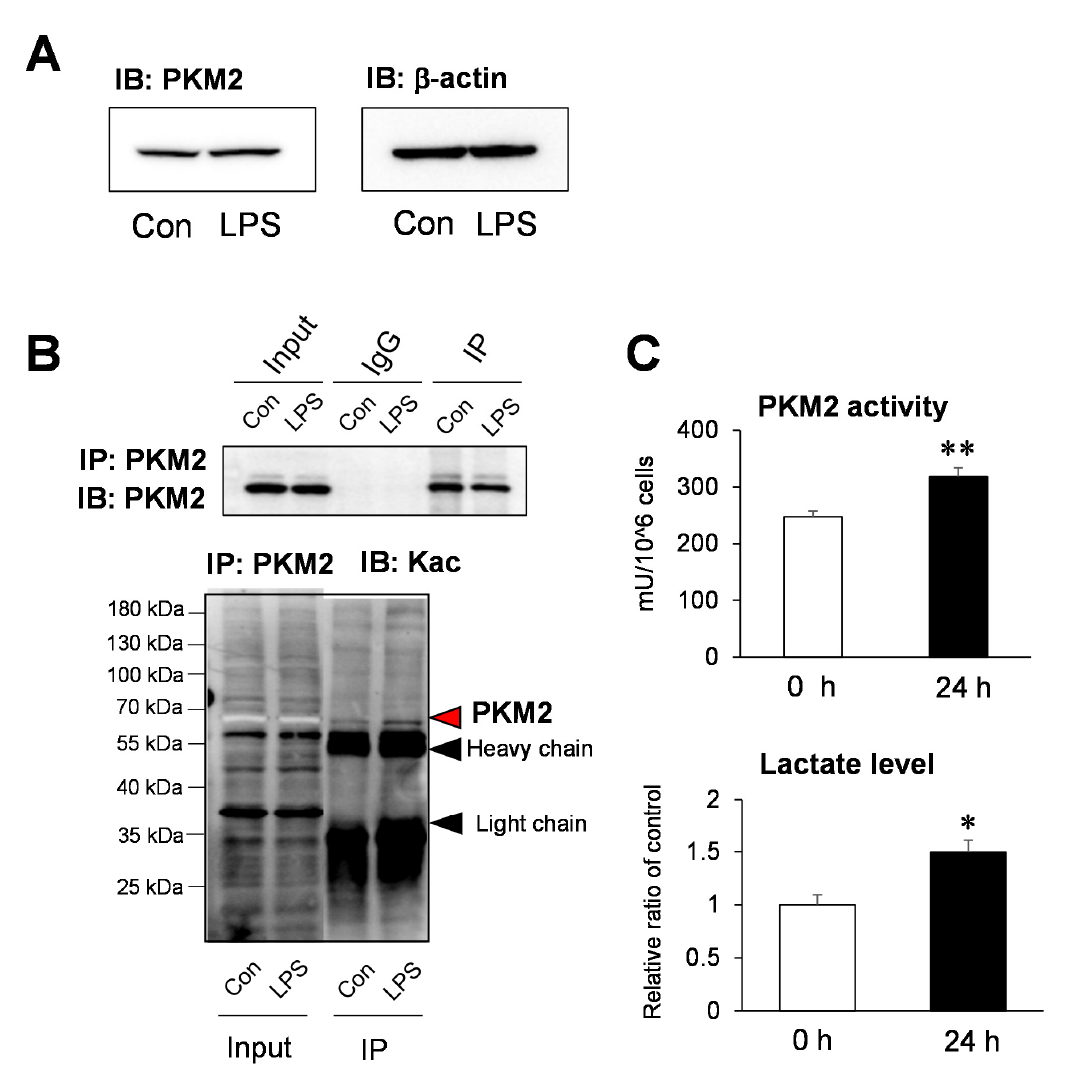
Figure 4. Pyruvate kinase M2 (PKM2) acetylation levels in sepsis-induced liver dysfunction (SILD). ( A ) Validation of comparative proteome analysis using Western blotting. Western blot analysis for PKM2 protein expression. ( B ) The PKM and PKM acetylation levels were determined using Western blotting after immunoprecipitation using an anti-PKM antibody. ( C ) Pyruvate kinase (PK) activity determination of control and LPS-treated HepG2 cells for 24 h. The PK activity was measured using ELISA (570 nm) ( n = 5). The comparison of the lactate level in control and LPS-treated HepG2 cells for 24 h ( n = 3). Data are mean ± SE. Statistical significance was assessed using student’s t -test and is represented as follows: * p < 0.05 and ** p < 0.01 vs.